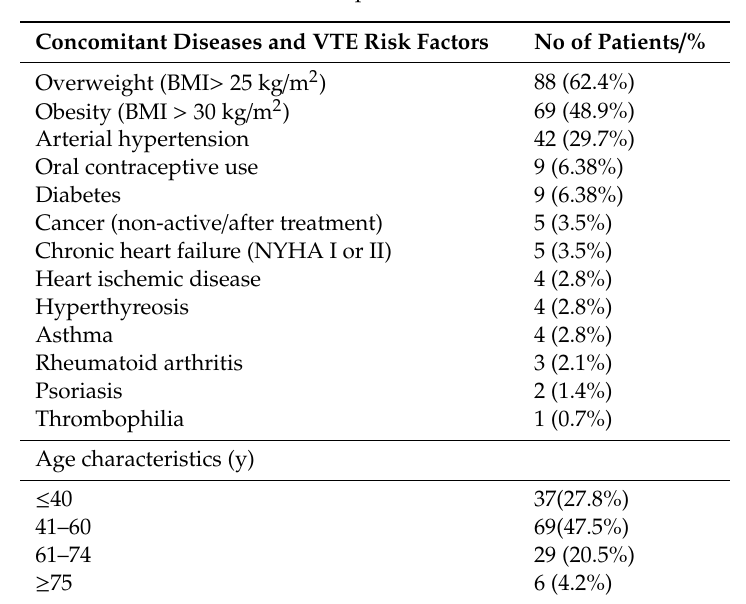
Table 1. Characteristics of the study population—preoperative evaluation of the concomitant disease as well as venous thrombo-embolism risk factor